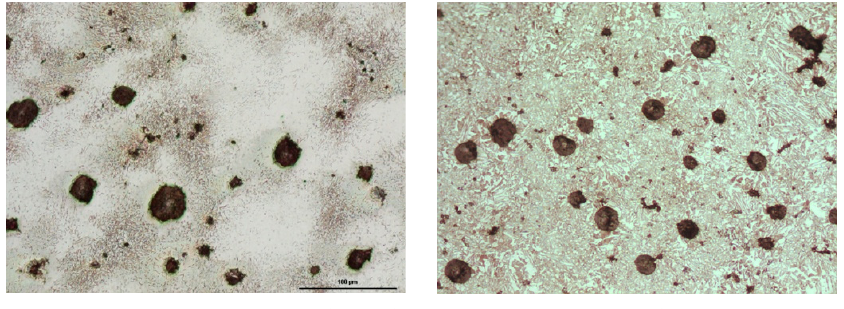
Figure 6: Ferritic-pearlitic DCI (obtained by means of a pearlitic DCI annealing). 50% ferrite – 50% pearlite.